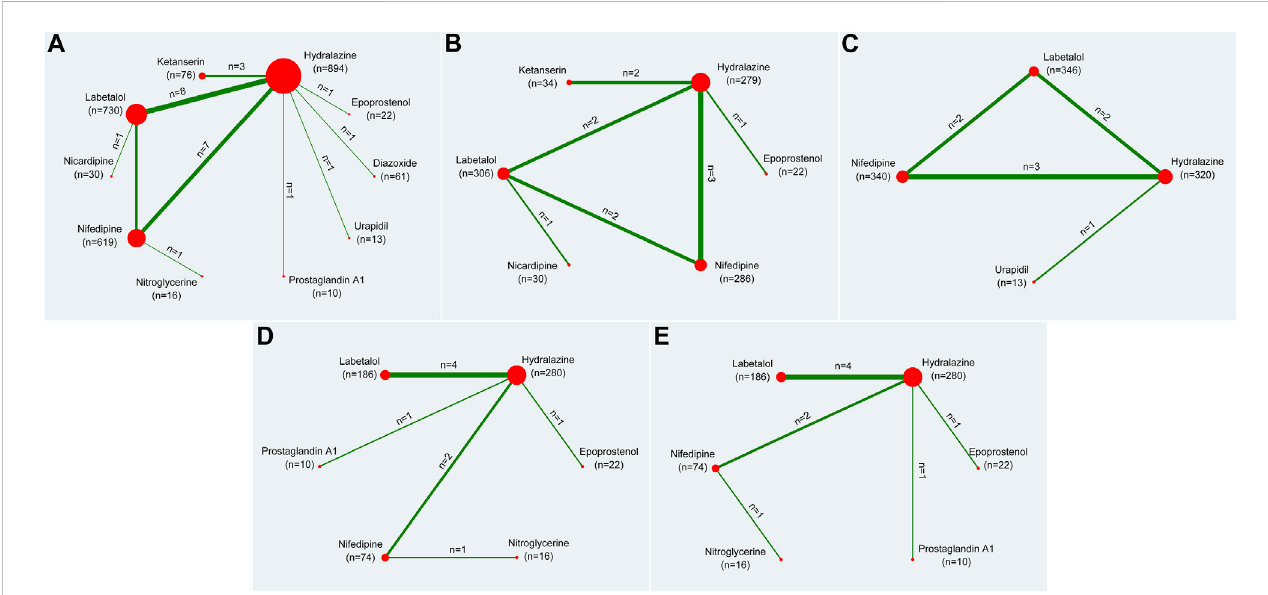
FIGURE 2 Network plots of all outcomes. Note: (A) indicated the rate of achieving target blood pressure, (B) indicated the time required to reach the target blood pressure, (C) indicated the dosage required to reach the target blood pressure, (D) indicated the systolic blood pressure, (E) indicated the diastolic blood pressure. The size of the nodes corresponds to the number of trials under study. The larger the node, the larger the number of participants in the study. The results of direct comparisons are connected by a line, the thickness of which corresponds to the sum of the sample sizes compared for each pairwise treatment. The thicker the line, the larger the sample size for